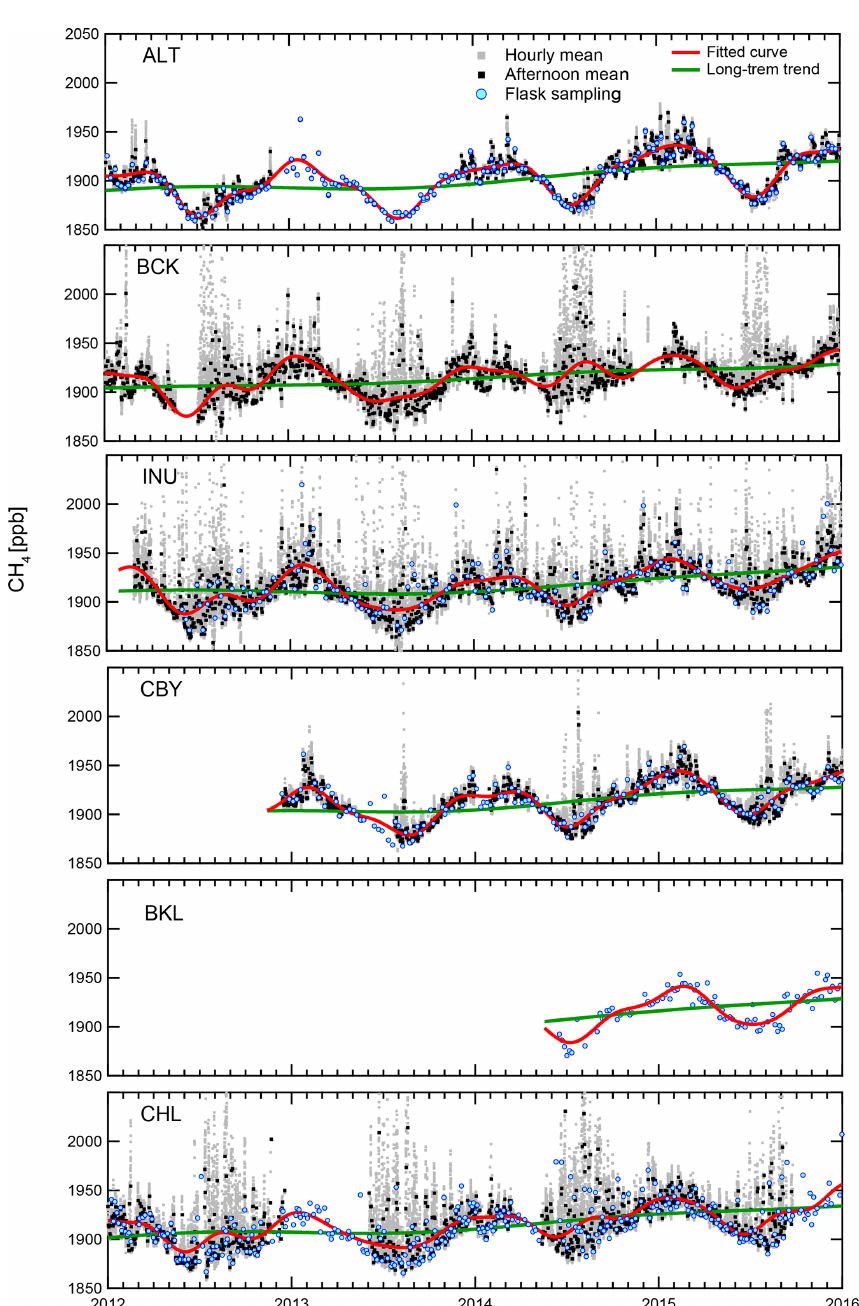
Figure 2. Time series of atmospheric CH 4 mixing ratios at Canadian Arctic sites. The observed values are the hourly means (grey dot), the afternoon means (black dot, 12:00–16:00 local time) from the continuous measurements, and the ones from flask sampling (circle in light blue). BCK has only continuous measurements. At BKL, flask air sampling is only available after being initiated in 2014. The red and green curves are fitted curves and long-term trends which are obtained by applying a fitting-curve method to the observed afternoon